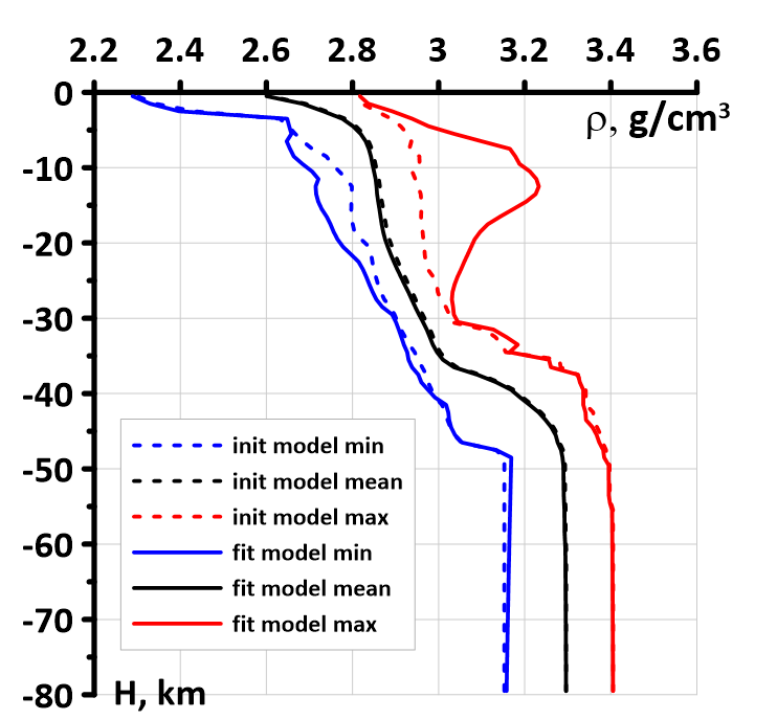
Figure 10. Fitted 3D density model.